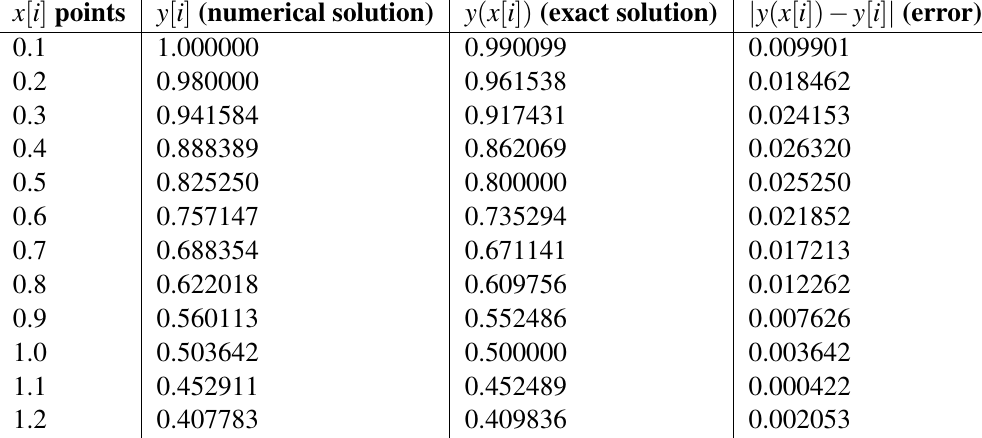
Table 3 B-theoretical algorithm calculation results